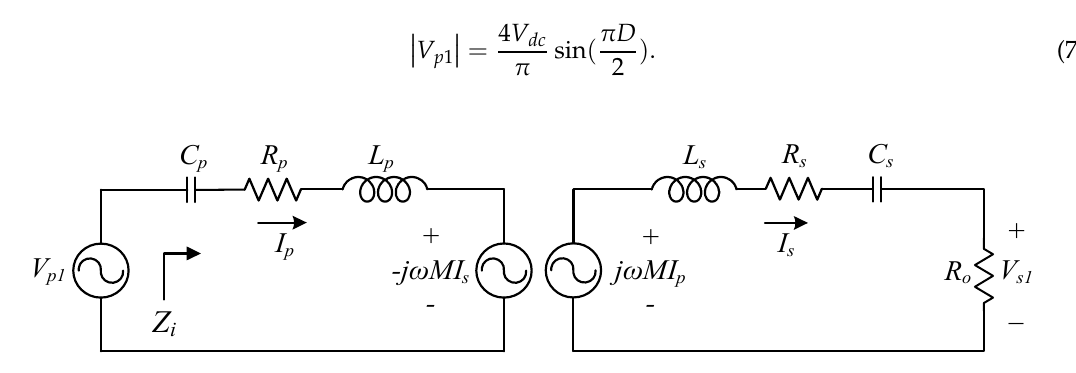
Figure 5. The equivalent circuit of the simplified WPT system.